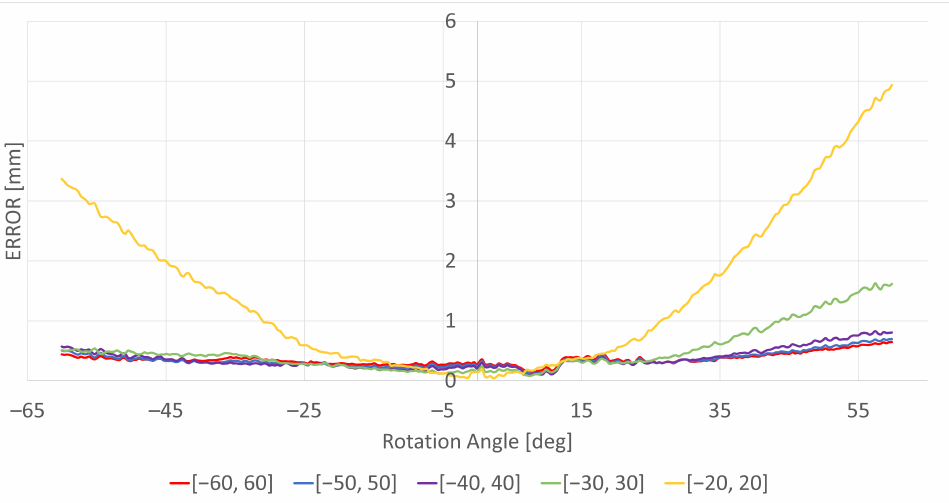
Figure 10. Graph of the projection mean errors according to the angle range with an angle interval of 0.4 degrees; the x-axis represents the rotation angle of each slice in the sinogram, and the y-axis represents the projection mean error of the eight corner points